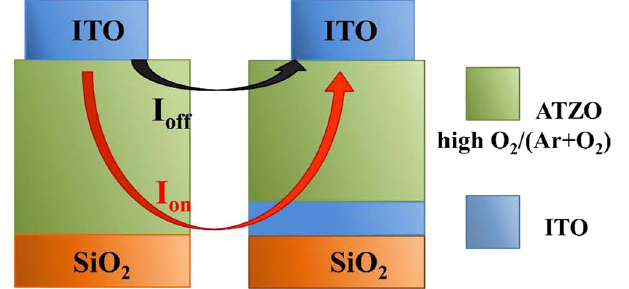
Figure 5. Schematic operation mechanism for (Left) single-channel ATZO and (Right) double-channel ITO/ ATZO TFTs.